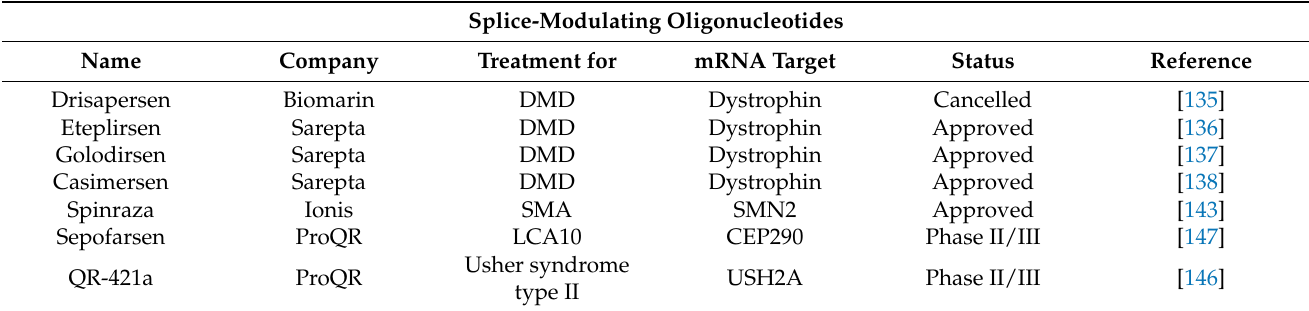
Table 3. Splice-modulating AON approved or in clinical